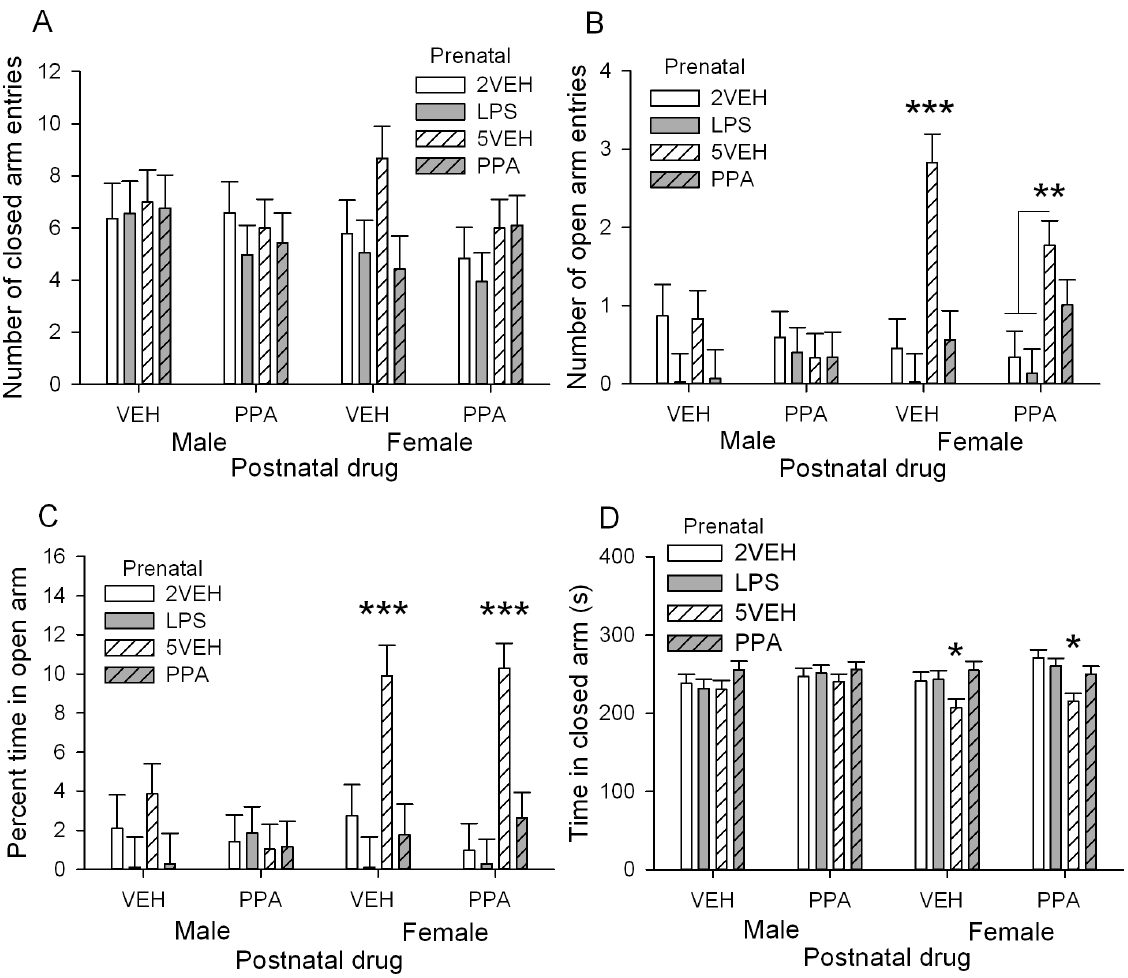
Figure 6. Elevated plus maze (P40) for male and female offspring. A: Number of closed arm entries was not significant. B: Number of open arm entries, C: Percent time in the open arm, D: Time in closed arm. Female offspring in the prenatal PPA treated group made less open arm entries, spent less time in the open arm, and spent more time in the closed arm than the prenatal 5VEH treated group. Error bars represent S.E.M. Refer to Table 1 for group designations and sample sizes. * p , 0.05, ** p , 0.01, *** p ,